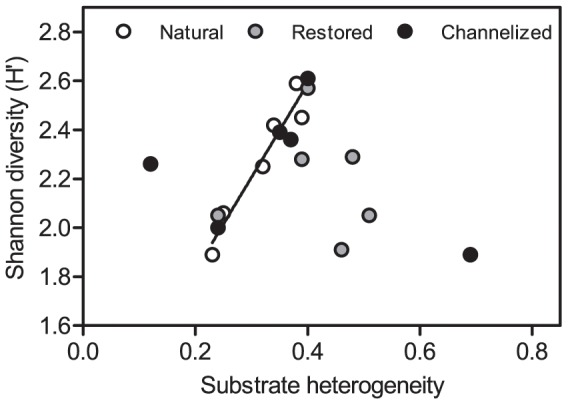
Relationship between substrate heterogeneity and macroinvertebrate community diversity for the 3 stream types.The solid regression line shows the significant relationship in natural streams.